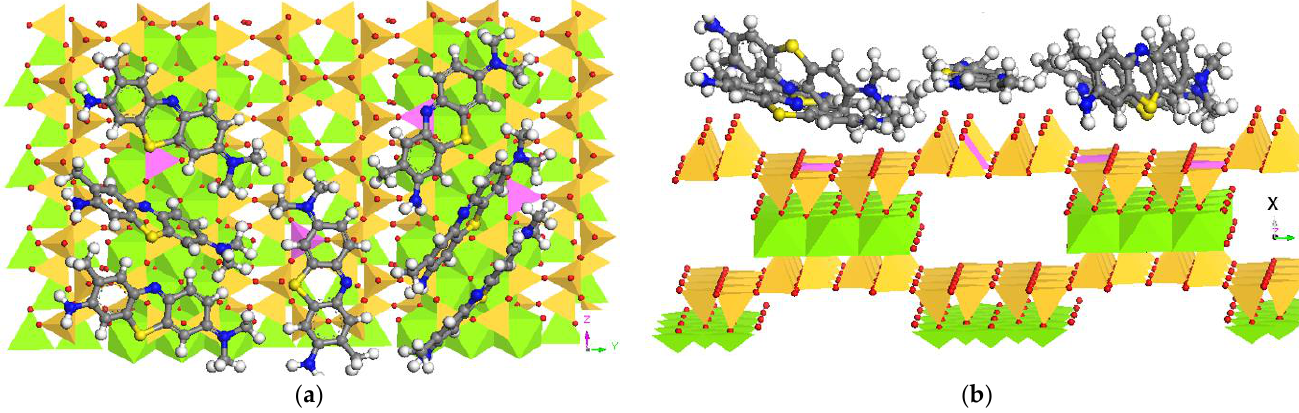
Figure 8. Molecular dynamic simulation showing the surface configuration of TB aggregates on the {100} surface ( a ) and projection along [001] ( b ) of PAL with 4 Si replaced with 4 Al in the supercell.